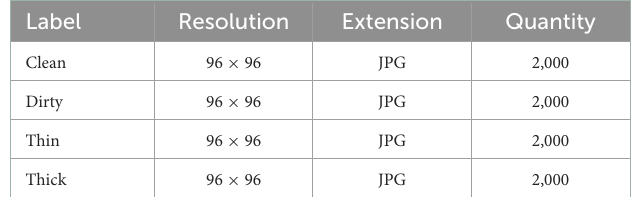
TABLE 1 Dataset description.